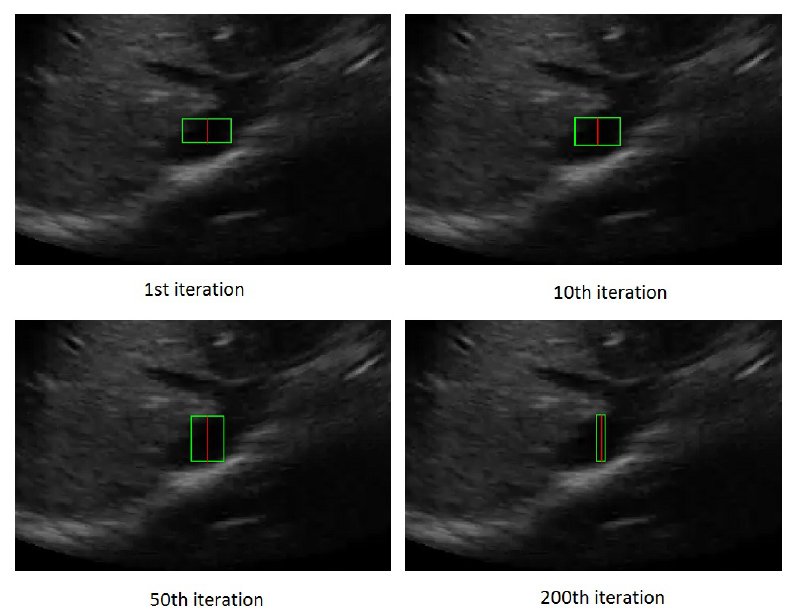
Figure 4. The rectangle evolution versus number of iterations.